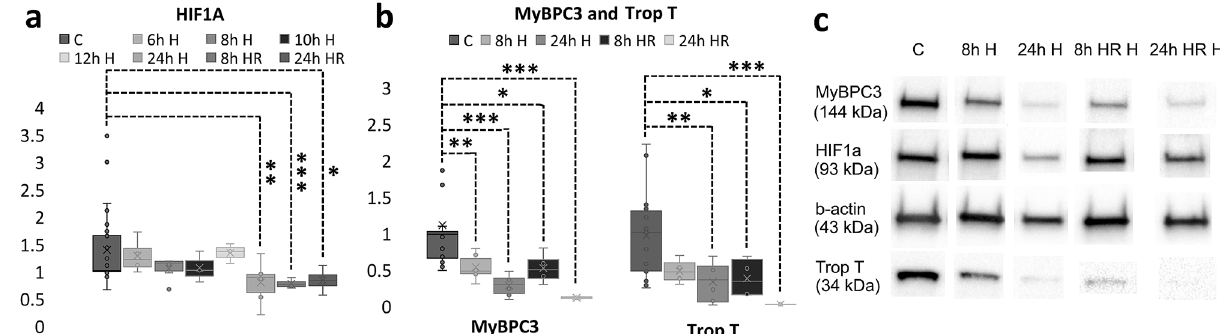
Figure 4. ( a ) HIF1α expression in control (n = 26) samples and in 6 h (n = 4), 8 h (n = 6), 10 h (n = 3), 12 h (n = 3) and 24 h (n = 6) hypoxia or 8 h (n = 4) and 24 h (n = 4) hypoxia-reoxygenation time points from western blot analysis presented as mean + standard deviation. During the first 12 h of hypoxia, there seems to be no significant changes in the expression of the protein, although in 6 h and 12 h samples there is a slight increase. On the other hand, after 24 h of hypoxia, as well as after 8 h hypoxia-reoxygenation there is a statistically significant decrease in the HIF1α expression. ( b ) Expression of MyBPC3 and Troponin T decreases during 8 h (n = 6) and 24 h (n = 6) hypoxia, and 8 h (n = 4) and 24 h (n = 4) hypoxia-reoxygenation compared to control (n = 20) samples. The expression is especially low in 24 h hypoxia-reoxygenation samples but has decreased also in other hypoxia samples. ( c ) Examples of the western blot bands. *p < 0.05; **p < 0.01; ***p <